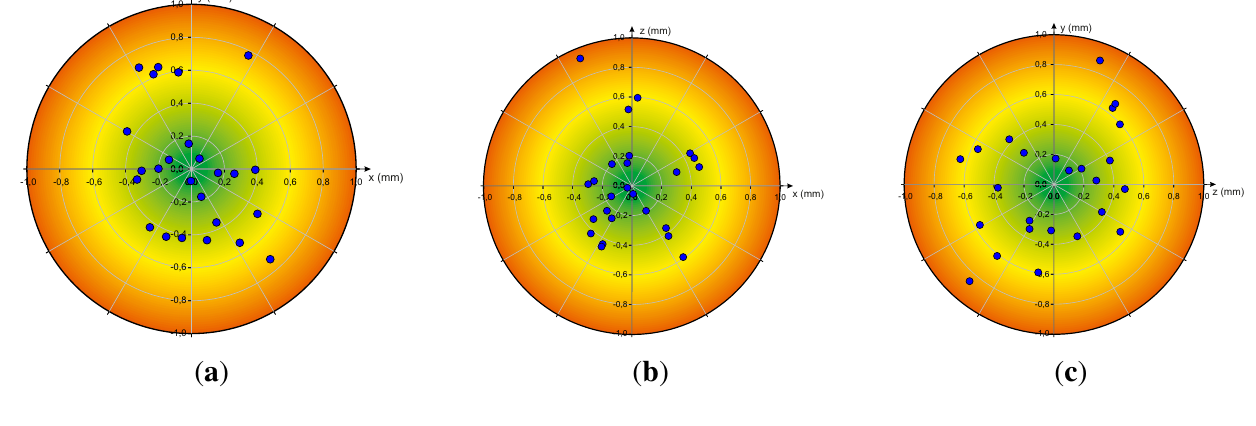
0,0 0,2 0,4 0,6 0,8